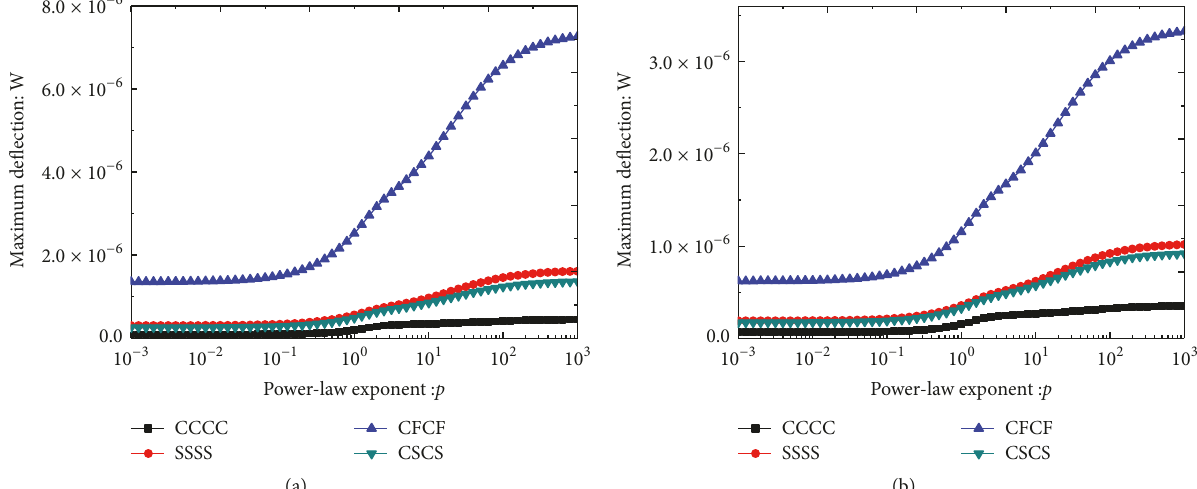
Figure 5: Variation of the static deflection versus the power-law exponent 𝑝 for Al/Al 2 O 3 plate with different uniform press: (a) entire rectangular plate; (b) part rectangular area [ (0.2,0.8),(0.5,1.5) ].